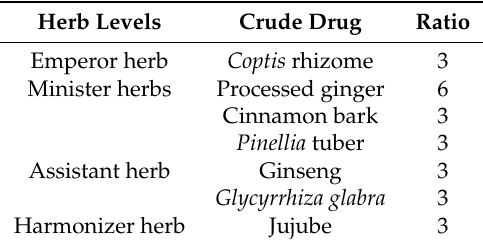
Table 1. Crude drug components of